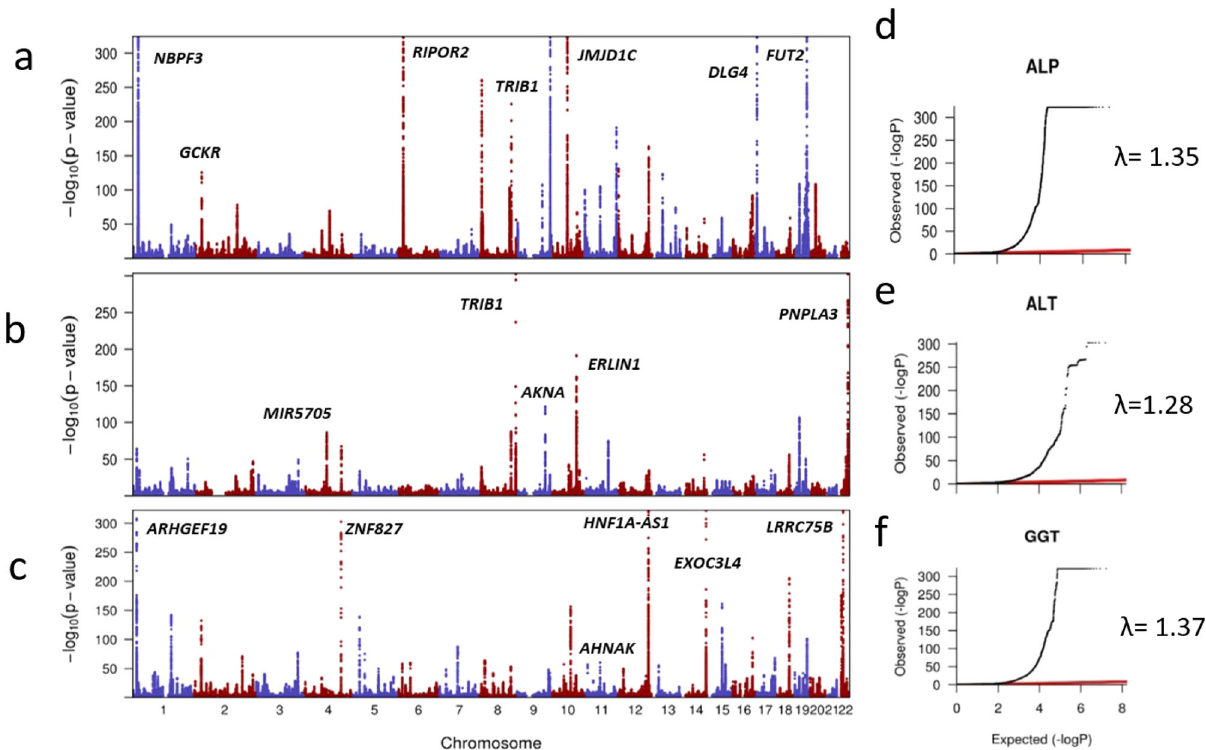
Fig. 2 Overview of ALT, ALP, and GGT loci identi fi ed within the UKB study (discovery sample). Manhattan (MH) plots illustrated have been created based on summary statistics of GWAs on liver enzymes where the x -axis demonstrates chromosome number and the y -axis represents − log 10 ( P value) for the association of SNP with liver enzymes. Q – Q plots are illustrated to show the in fl ation of test statistics using the summary statistics of the liver enzyme GWAS. Where the x -axis represents the expected log ( P value). The red line shows the expected results under the null association. Y -axis illustrates the observed log ( P value). a MH plot based on ALP GWAS summary statistics. b MH plot based on ALT GWAS summary statistics. c MH plot based on GGT GWAS summary statistics. d Q – Q plots for ALP, e Q – Q plots for ALT, and f Q – Q plots for GGT. In fl ation of test statistics was represented by lambda ( λ ) values.